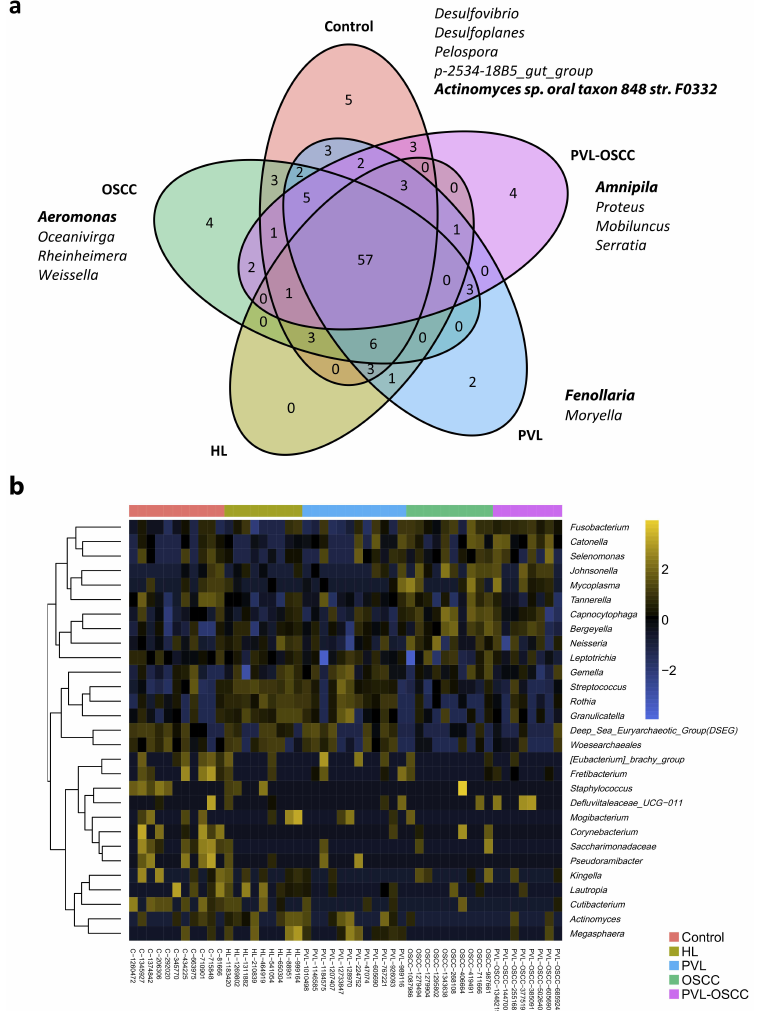
Figure 3. Differently abundant genera between samples from healthy donors, HL, PVL, OSCC, and PVL-OSCC patients. ( a ) Venn diagram summarizing the distribution of genera along groups. ( b ) Clustering of the differentially distributed genera along samples as selected by elastic net